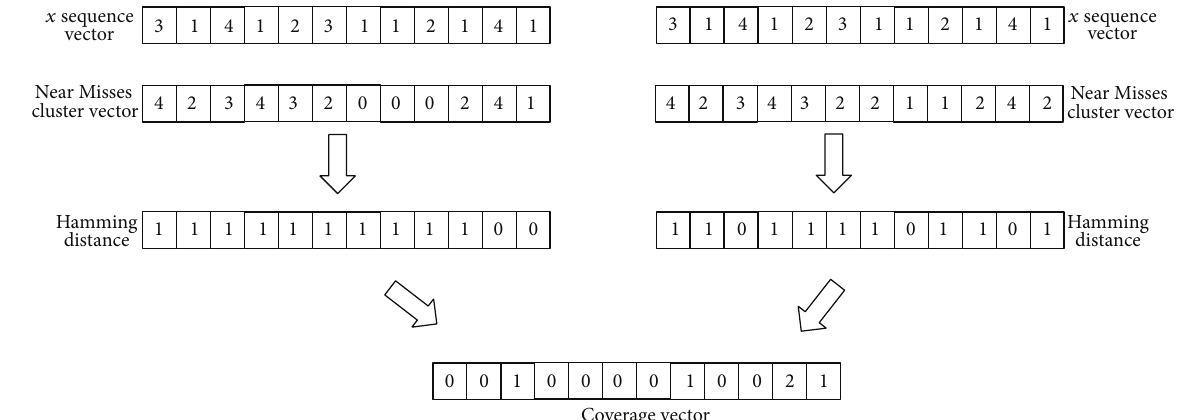
Figure 15: Coverage vector computation by Hamming